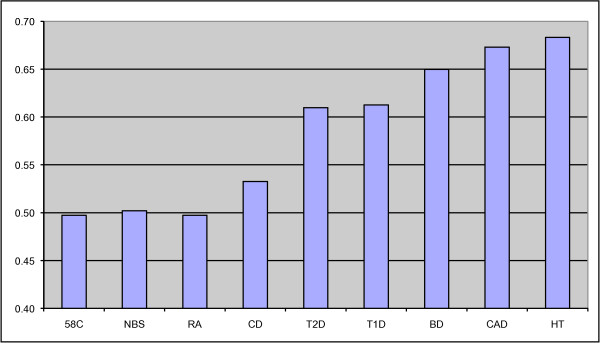
Proportion of each of the nine populations having low measured intensity at rs7761068. The intensity thresholds were chosen so that 50% of the combined control population would have low intensity.